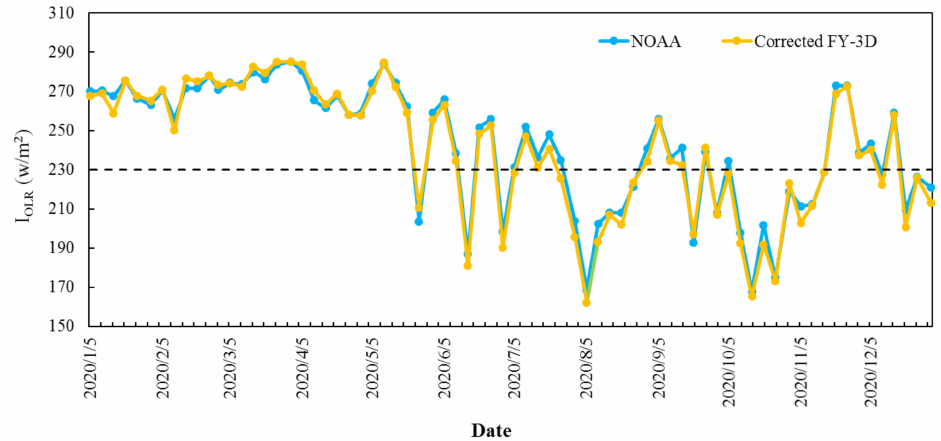
Figure 7. Variations in the pentad average of the average OLR ( I OLR ) for NOAA and the corrected FY-3D data from the first pentad of January to the sixth pentad of December